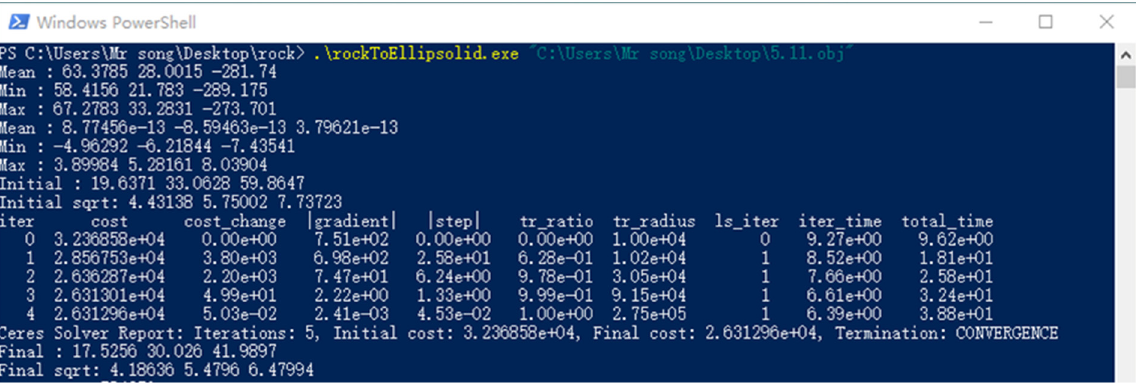
Figure 4. Calculation result of fi tt ing ellipsoidal model.